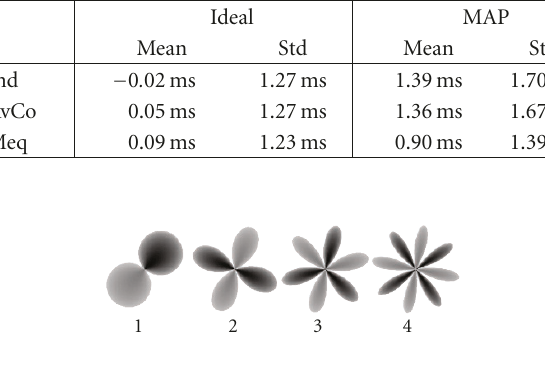
Figure 14: Rotated elementary directivity functions.